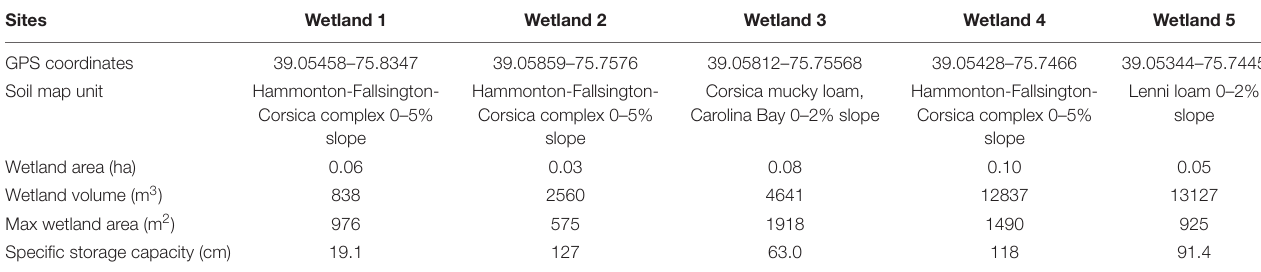
TABLE 1 | Location and morphological description of the five sampled Delmarva wetland sites (Maryland, United